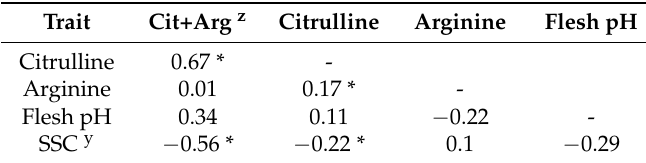
Table 5. Pearson correlation coefficients of the five compositional components tested across all 21 cucurbit taxa. Trait Cit+Arg z Citrulline Arginine Flesh pH Citrulline 0.67 * - Arginine 0.01 0.17 * - Flesh pH 0.34 0.11 − 0.22 - SSC y − 0.56 * − 0.22 * 0.1 −